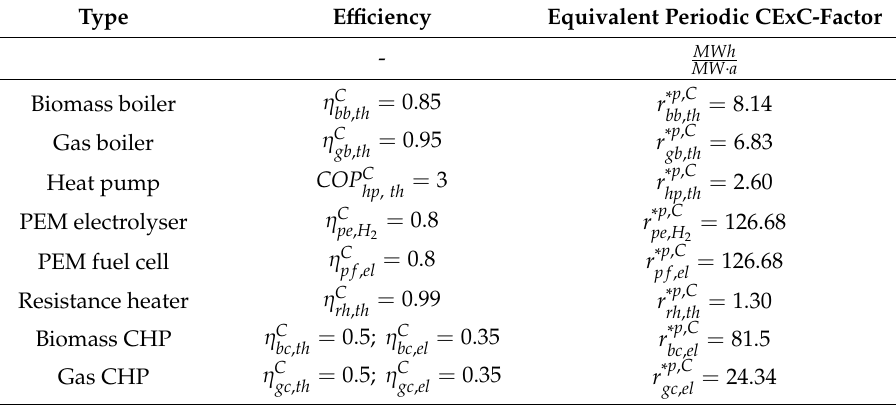
Table A4. Conversion units.